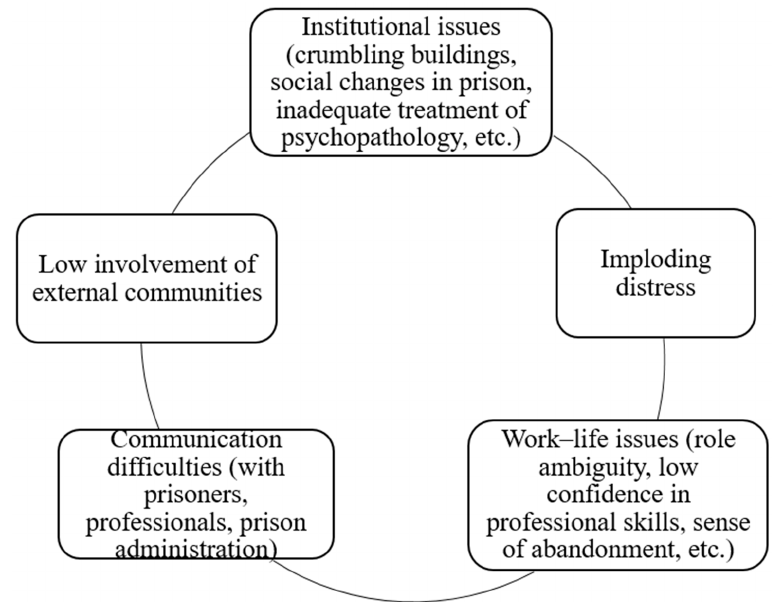
Figure 2. Circle of critical points.